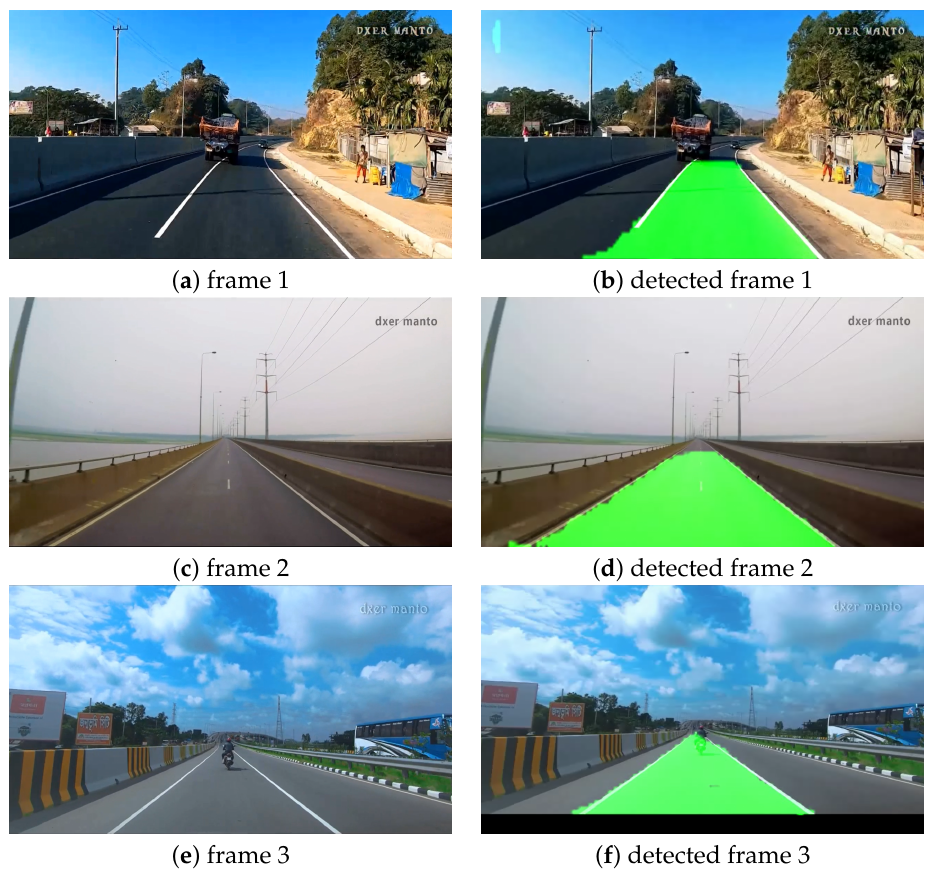
Figure 5. Visualization of lane detection in perfect road and weather